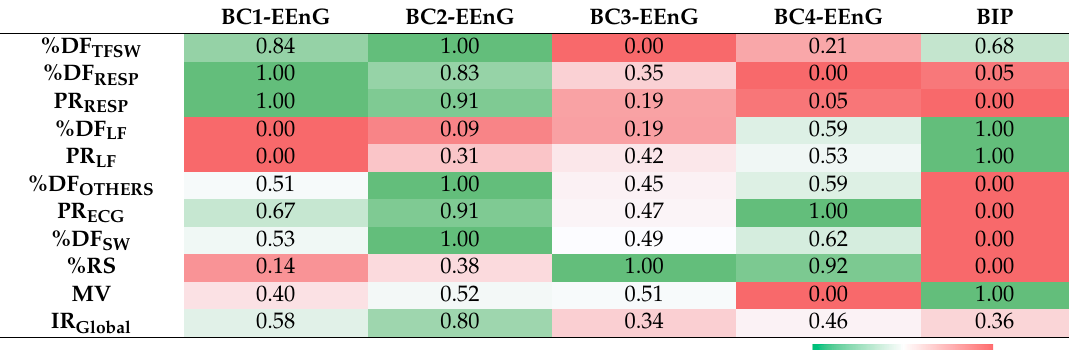
Table 6. IR values for the concentric bipolar records (BC1-EEnG, BC2-EEnG, BC3-EEnG, BC4-EEnG) in BN position and using adhesive material and conventional bipolar (BIP) in BN position, for the 10 characteristic signal parameters.